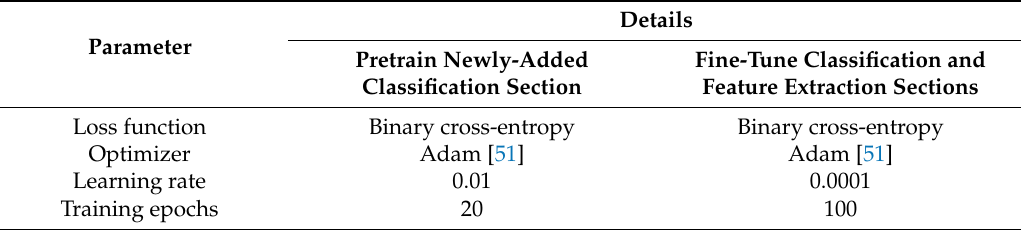
Table 3. CNN training parameters during contrast-based learning for Method II.